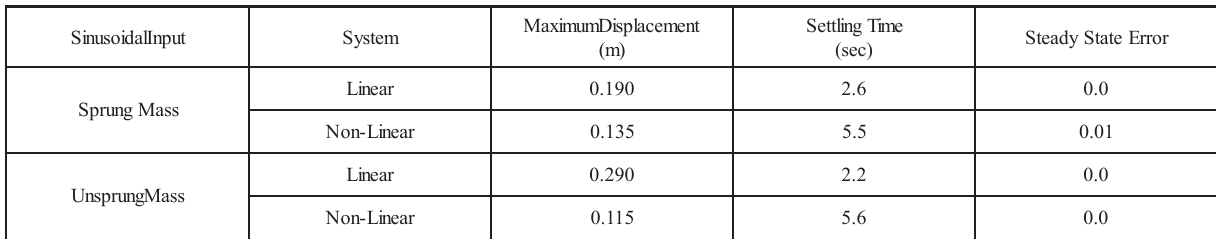
TABLE 3. TRANSIENT RESPONSE FOR SINUSOIDAL INPUT